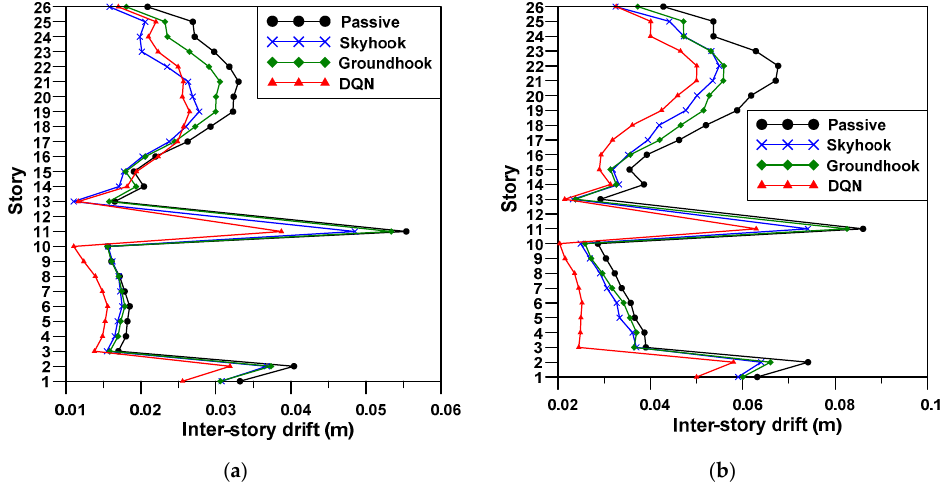
Figure 17. Peak inter-story drift of each control algorithm: ( a ) responses to EV1, ( b ) responses to EV2.